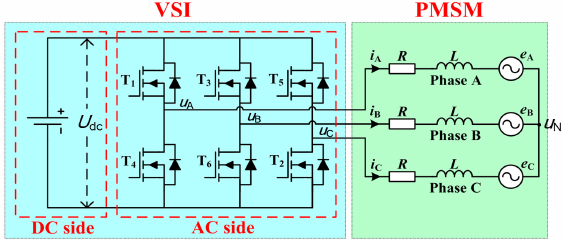
Figure 1. Diagram of equivalent circuit for a voltage source inverter (VSI)-permanent magnet synchronous motor (PMSM)